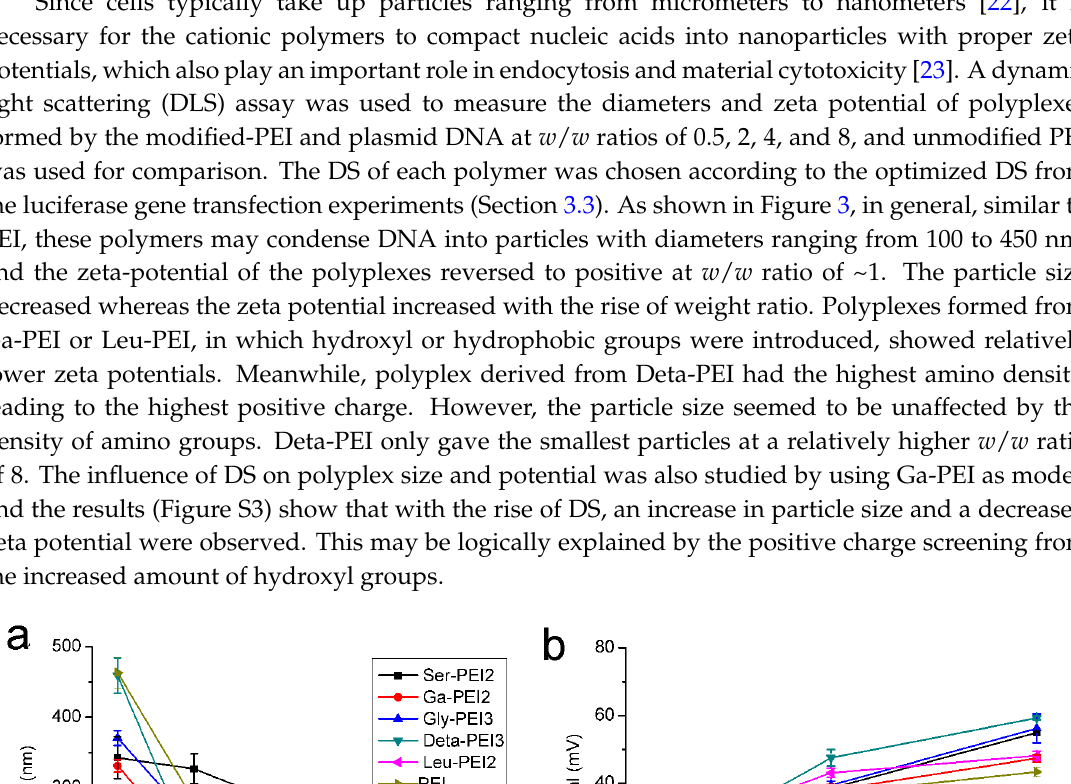
Figure 4. Luciferase gene expression transfected by polyplexes at different weight ratios in comparison with 25 kDa PEI ( w / w = 1.4, N/P = 10) in U-2OS cells in the absence of serum. In each group of columns, the w / w are 2, 3, 4, and 5, consecutively. Data represent mean ± SD ( n = 3).